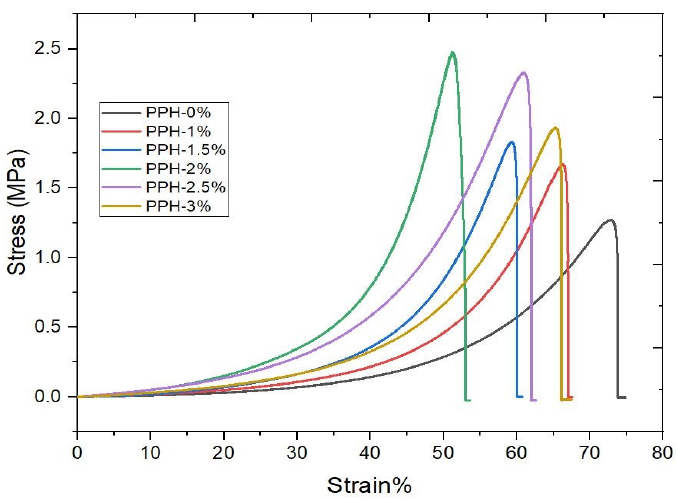
Figure 5. Mechanical characterization of composite hydrogels under unconfined compression. Table 2. Properties of PVA/PVP/HNr hydrogel under unconfined